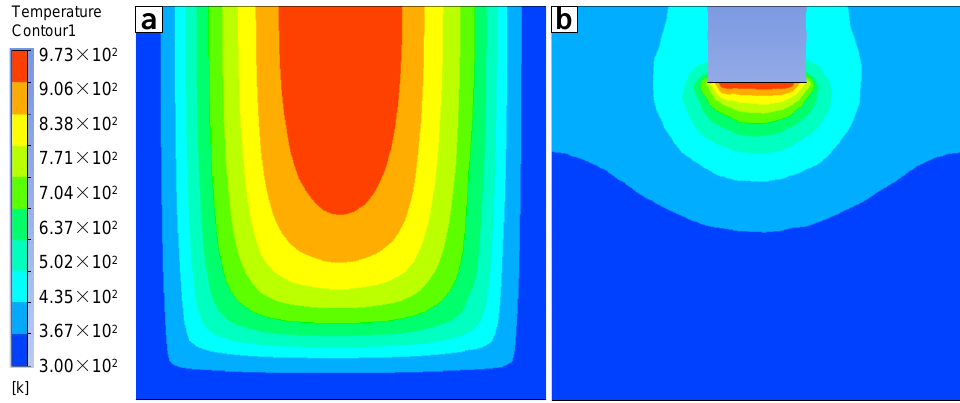
Figure 11. Comparison of temperature distribution between ( a ) no ultrasonication and ( b ) ultrason- ication.